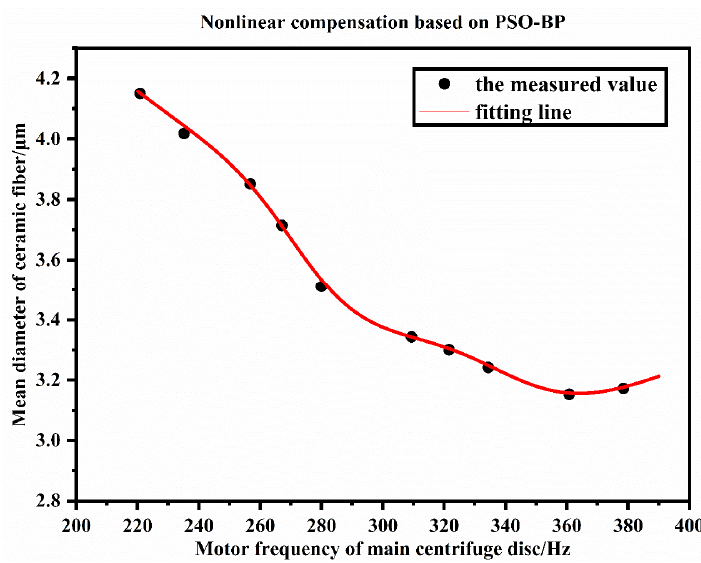
Figure 8. Nonlinear compensation model based on improved PSO ‐ BP.